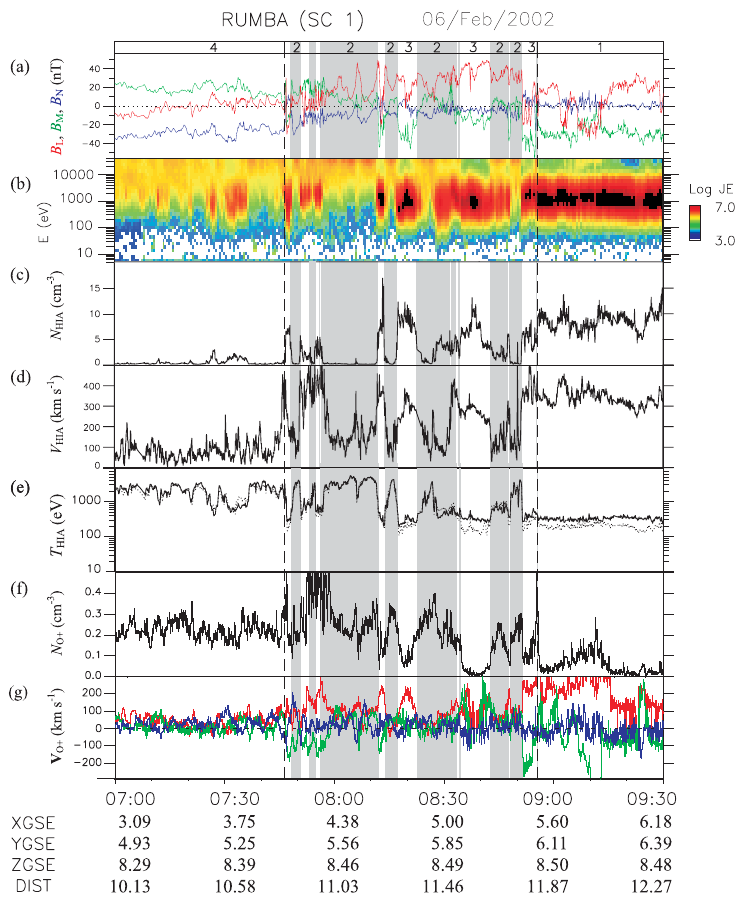
Fig. 6. Measurements in the MSP/MP/MSH from Cluster SC1 on 6 February 2002. The format is the same as in Fig.